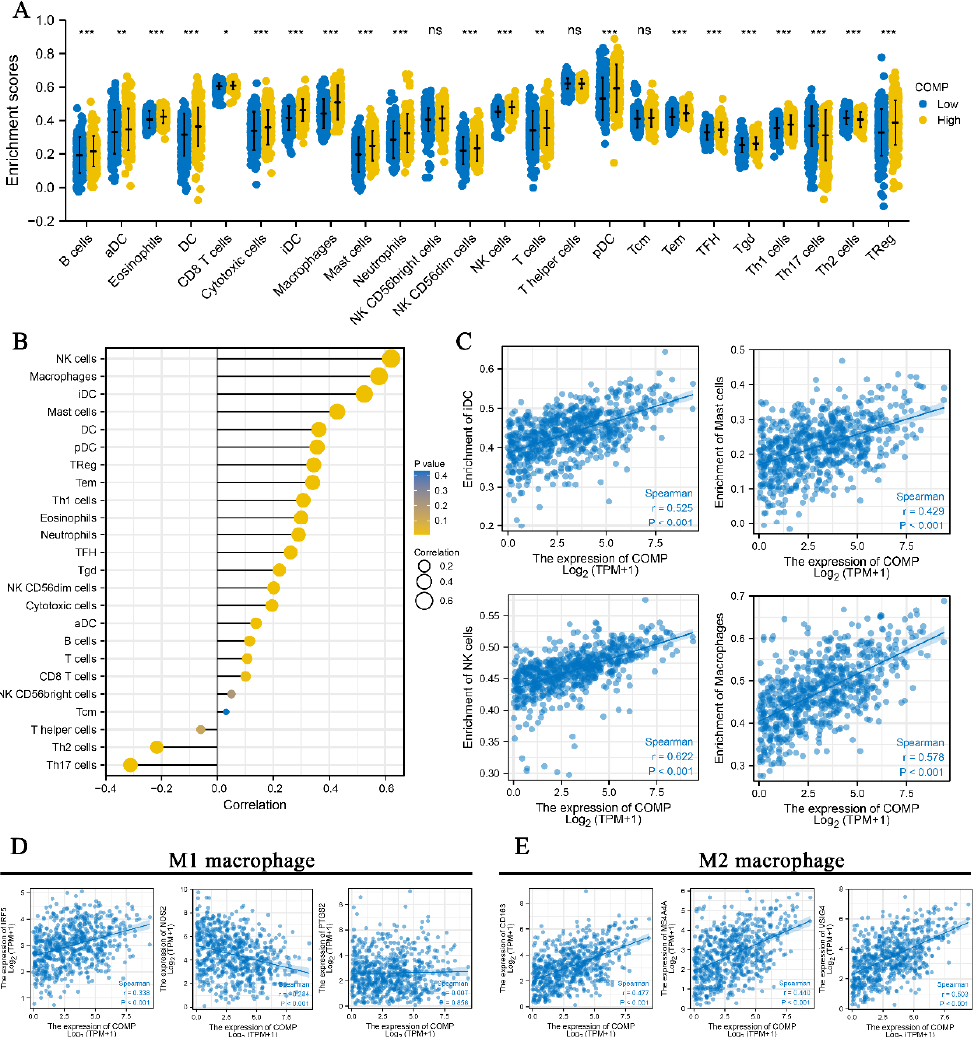
Figure 6. The correlation between COMP and immune infiltration in CRCs. ( A ) The immune infil- tration difference between patients with low and high COMP expression levels. ( B ) The correlation between COMP and immune infiltration of 24 immune cells. ( C ) The correlation between COMP and immune infiltration of iDC, NK, mast cells, and macrophages. ( D ) The correlation between COMP and biomarkers of M1 macrophages. ( E ) The correlation between COMP and biomarkers of M2 macrophages. * p < 0.05, ** p < 0.01, *** p <